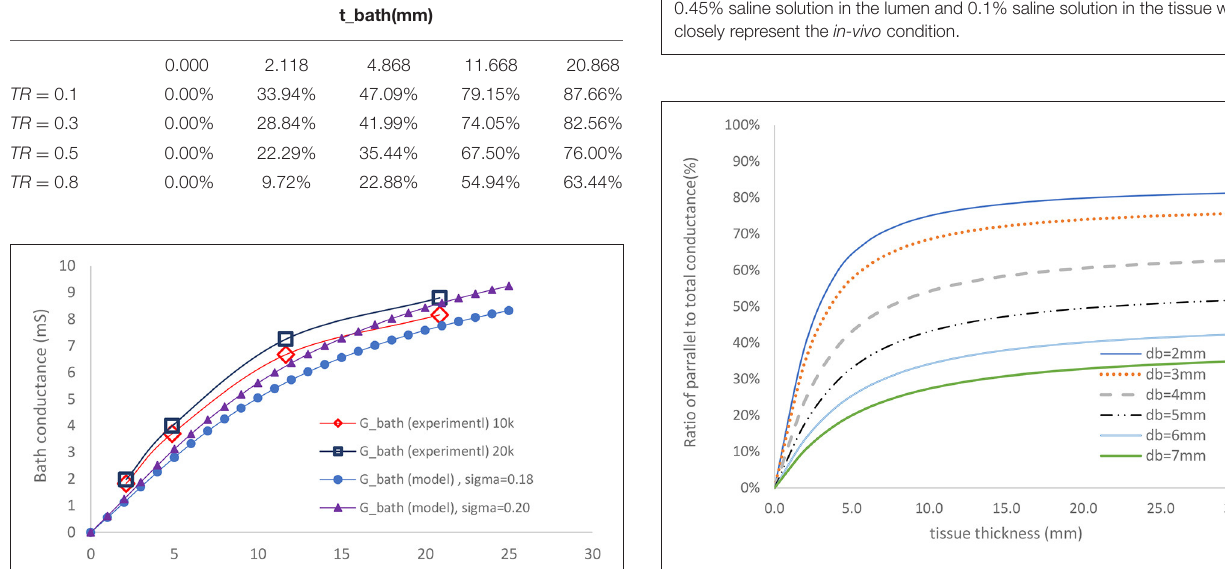
FIGURE 5 | Ratio of parallel conductance to the total conductance for various lumen diameters for 2-2-2 guidewire based on model predication. There is 0.45% saline solution in the lumen and 0.1% saline solution in the tissue which closely represent the in-vivo condition.